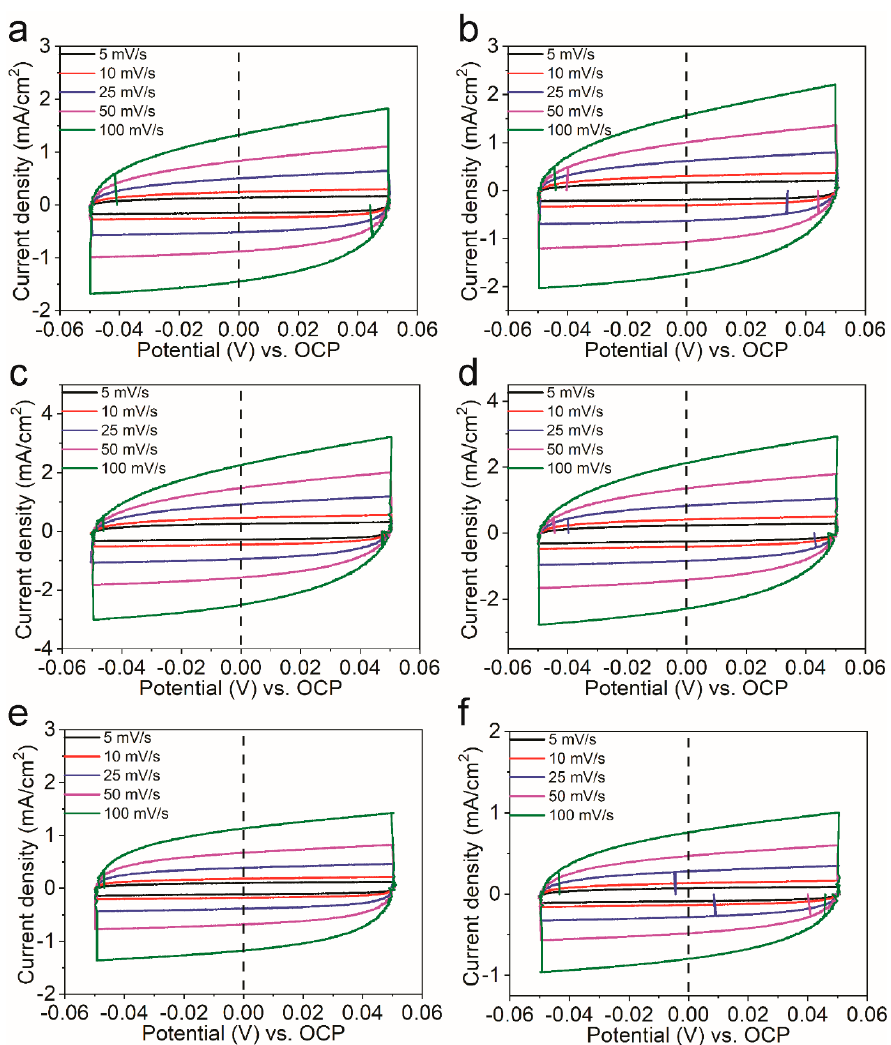
Figure 5. Cyclic voltammograms of ( a ) Ni 95 Ce 5 O x , ( b ) Ni 90 Ce 10 O x , ( c ) Ni 75 Ce 25 O x , ( d ) Ni 50 Ce 50 O x , ( e ) Ni 25 Ce 75 O x and ( f ) Ni 10 Ce 90 O x catalysts tested in a region with non–Faradaic process of the voltammogram with the scan rate of 5 mV/s, 10 mV/s, 25 mV/s, 50 mV/s and 100 mV/s. The value of the open circuit potential was 1.27 V vs. RHE.